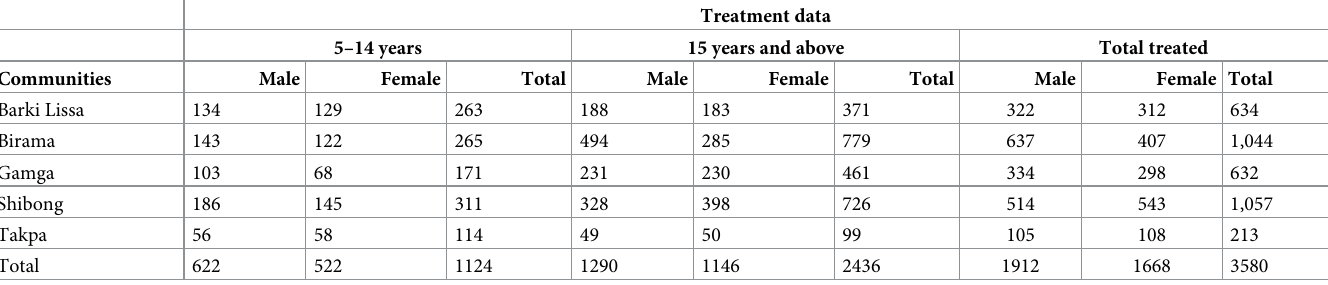
Table 5. Praziquantel treatment data across the study